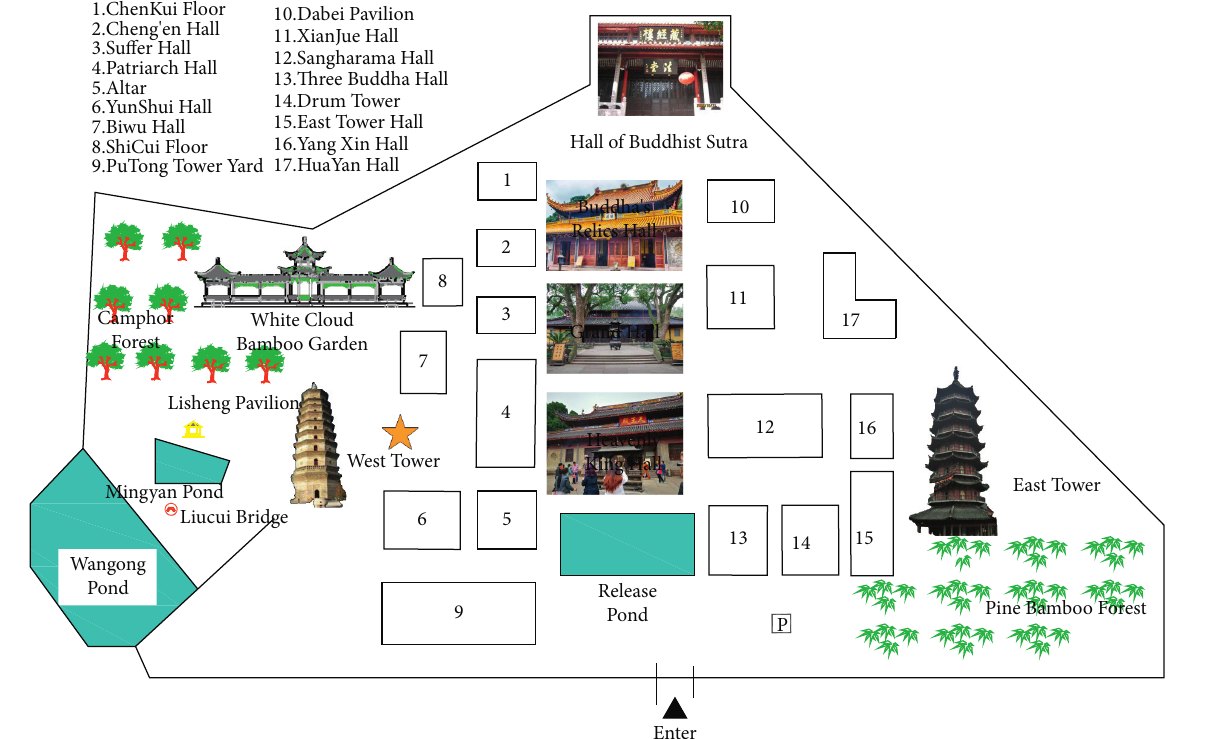
Figure 7: The plan of the Asoka Temple.